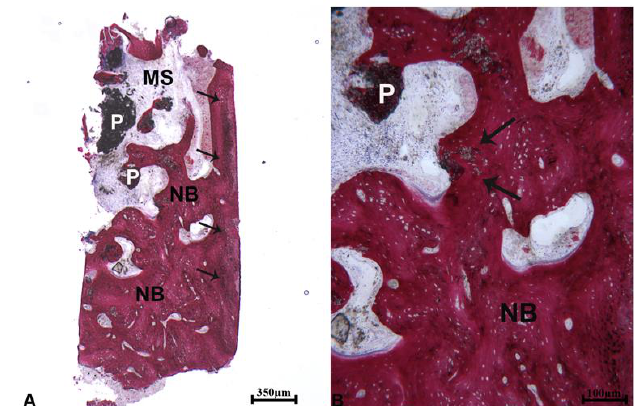
Figure 2. ( A ) Light microscopic ground sections of the specimen showed two-dimensional histological micro-structure of bone biopsy composed of a portion of bone wall (PB) lining the newly formed bone (NB) with small marrow spaces (MS) and residual biomaterial particles (P) (acid fuchsin–toluidine blue, 12X). ( B ) Residual biomaterial particles (P) were embedded into newly formed bone (NB). Indeed,